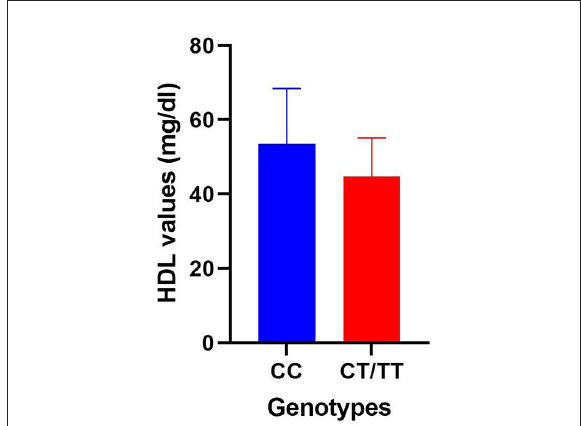
FIGURE1 Comparison of HDL mean values within the obese/overweight group divided between homozygous CC genotype and a group consisting of variant heterozygous and homozygous genotypes for the PPARGC1A rs3856806